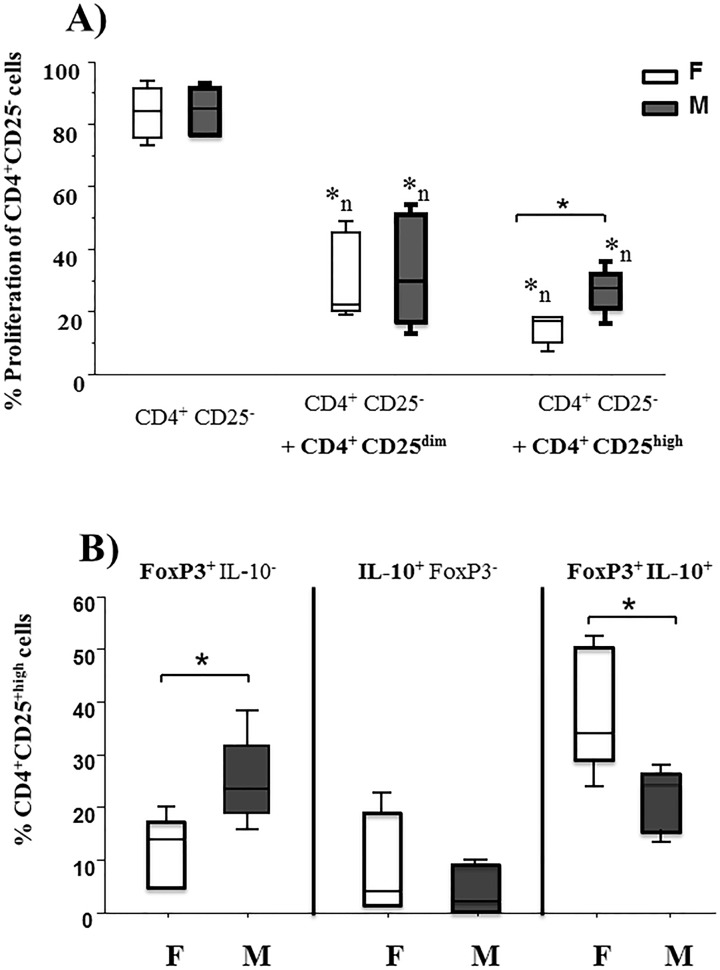
Suppressive ability of CD4+CD25+ cells and proportion of IL-10+FoxP3+ within CD4+CD25high cells from foals and mares.5x105 CD4+CD25− lymphocytes sorted from freshly isolated PBMC of foals (F, n = 5, age 1–2 months) and mares (M, n = 5, 5–17 years) were labelled with carboxyfluorescein diacetate succinimidyl ester (CFSE) and cultured with 5x105 irradiated allogeneic PBMC alone (CD4
+
CD25
−) or in the presence of CD4+CD25dim
(CD4
+
CD25
−
+ CD4
+
CD25
dim) or CD4+CD25high
(CD4
+
CD25
−
+ CD4
+
CD25
high) cells in a ratio of 1: 0.25. After 4 days, the cells were harvested and stained for FoxP3 and IL-10. The percentage of proliferation (A) and of single positive FoxP3
+IL-10−, single positive IL-10
+FoxP3− and double positive IL-10
+
FoxP3
+
(B) was measured by flow cytometry. Results are shown as percentage. Results from all horses examined are presented as box plots. An asterisk with line indicates statistical significance difference. *n indicates significance difference to CD4
+
CD25
− cells within same group of horses. Comparisons were performed using non-parametric Mann-Witney U test. *p ≤0.05 was considered significant.